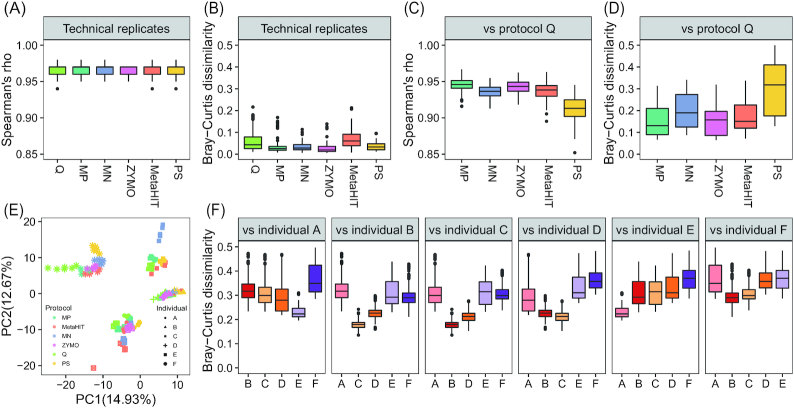
Intra- and interprotocol consistency in species quantification using human fecal samples. A, B, Spearman ρ (A) and Bray-Curtis dissimilarities (B) between 6 technical replicates within each protocol. C, D, Spearman ρ (C) and Bray-Curtis dissimilarities (D) between protocol Q and the 5 other protocols. E, Principal component analysis (PCA) based on species profile. Colors indicate different protocols: light green, protocol Q; green, protocol MP; blue, protocol MN; purple, protocol ZYMO; orange, protocol MetaHIT; yellow, protocol PS. Different shapes indicate DNA samples from different individuals. F, Box plots showing the inter-individual Bray-Curtis dissimilarities using the same protocol. Each panel indicates Bray-Curtis dissimilarities between samples from a given individual and that from others. The boxs represent the range between the first and the thired quartiles and the vertical line inside the box represent the median.